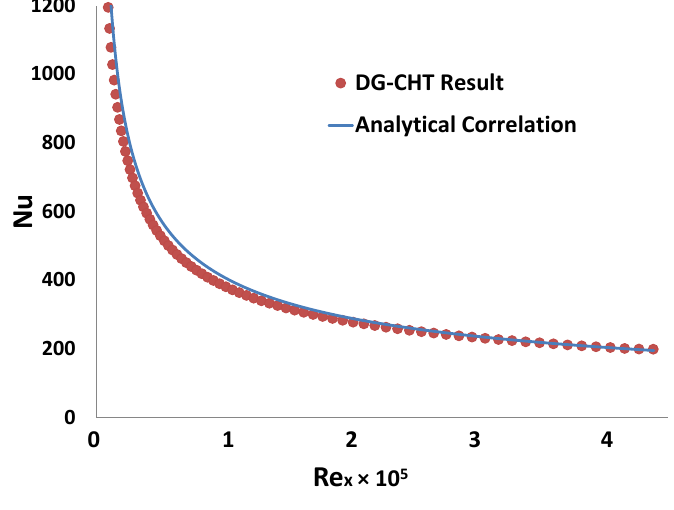
Figure 4. Comparison of the computational and analytical Nusselt number when λ s /λ f ≈ 9 × 10 3 .